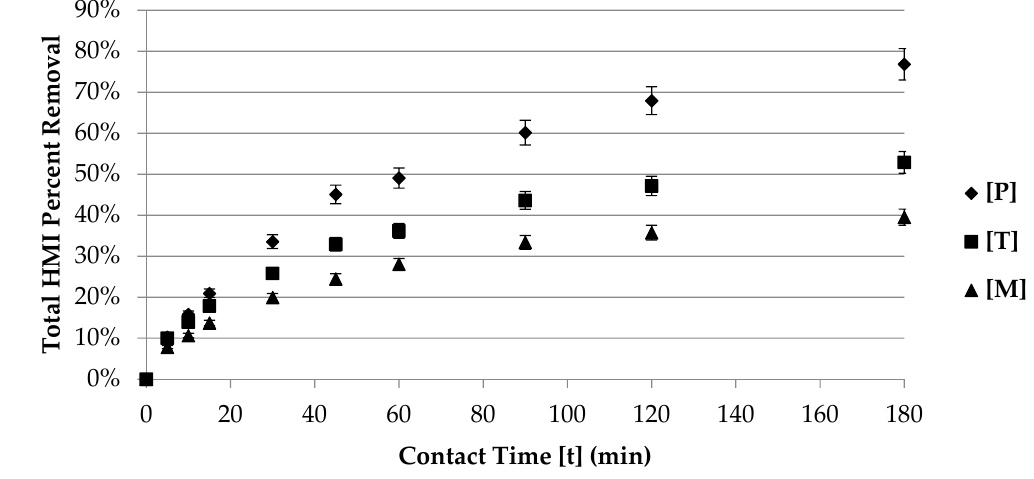
Figure 1. Total HMI percent removal versus contact time.